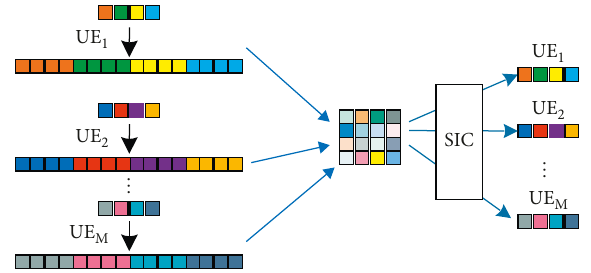
Figure 3: SIC schematic